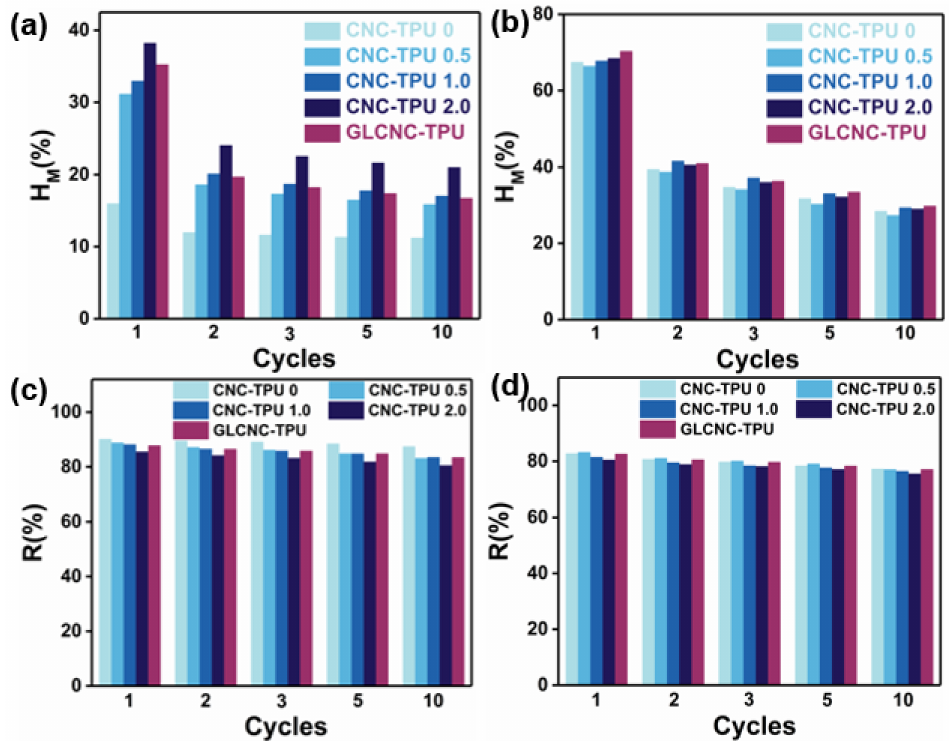
Figure 7. H m of CNC/TPU and GLCNC-TPU composite films at ( a ) 50% strain and ( b ) 500% strain. R of CNC/TPU and GLCNC-TPU composite films at ( c ) 50% strain and ( d ) 500%